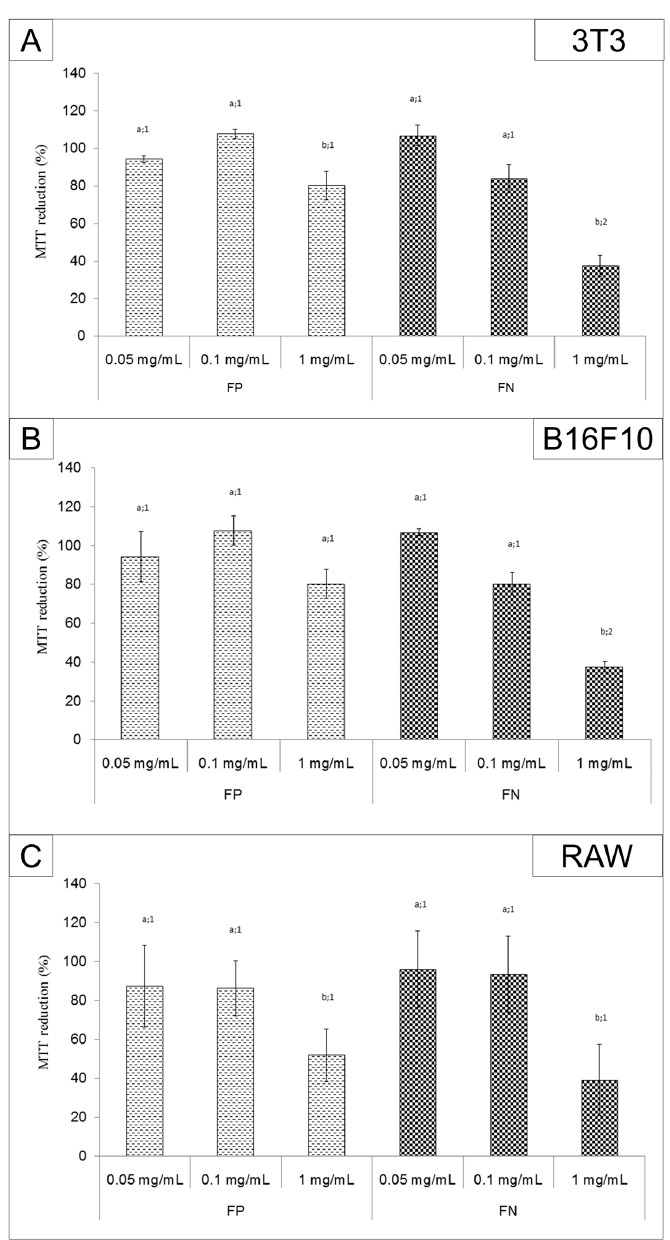
Figure 6. 3-(4,5-dimethylthiazol-2-yl)-2,5-diphenyl-tetrazolium bromide (MTT) assay performed with ( A ) 3T3; ( B ) B16F10; and ( C ) RAW cells. The cells (1 × 10 4 ) were exposed to Dulbecco’s modified Eagle’s medium (DMEM) containing the samples at concentration of 0.01, 0.05, 0.1, and 1 mg/mL for 24 h. Afterwards the cells’ ability to reduce MTT was measured as described in Methods. Different letters (a,b) represent the significant difference between FP or FN at different concentrations; different numbers (1,2) represent the significant difference between FP and FN in the same concentration by ANOVA followed by Newman-Keuls test ( p < 0.05).